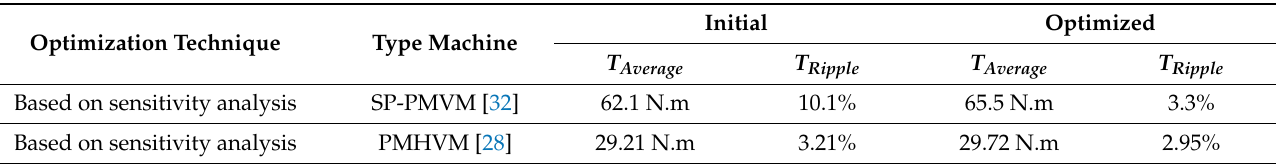
Table 7. A comparison of the quantity values with recent works.